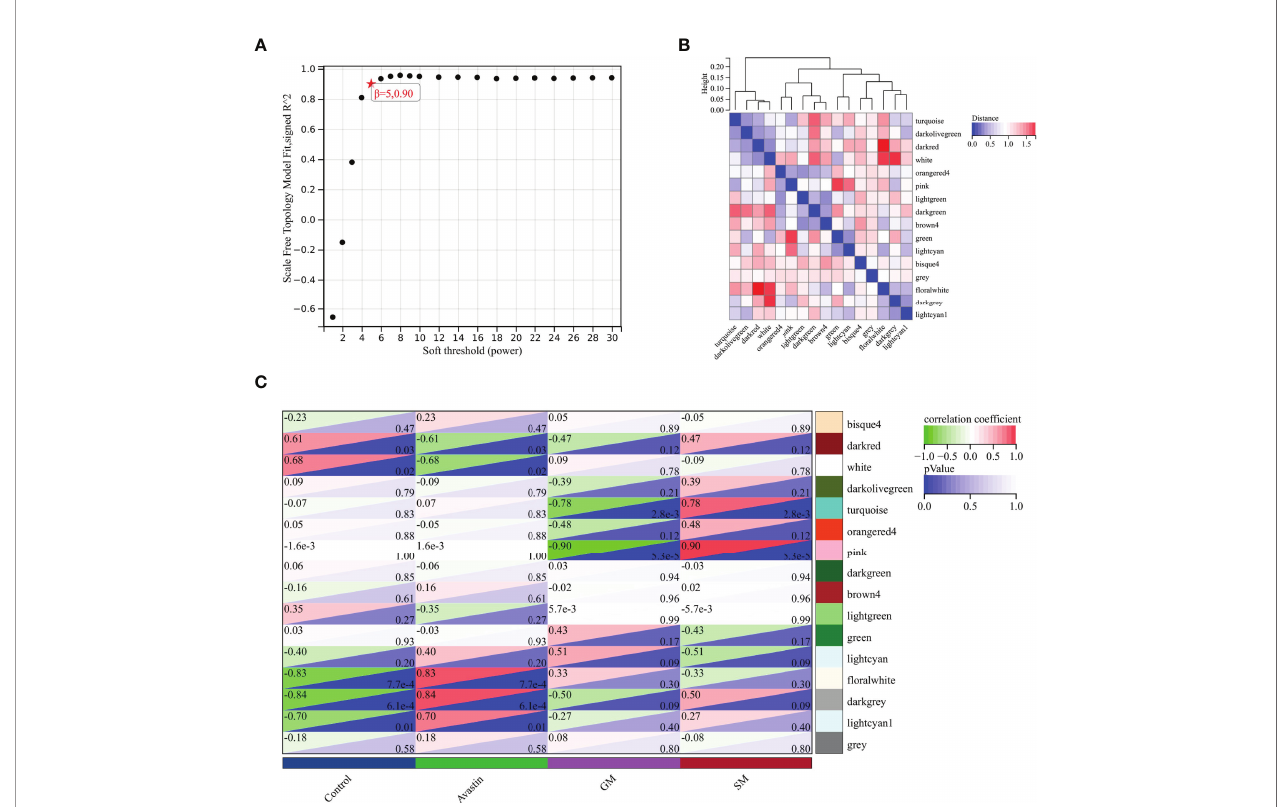
FIGURE 2 | Selection of key gene modules. (A) Determination of soft threshold; (B) Heat map of module feature vector clustering; (C) Heat map of correlation between gene modules and traits.